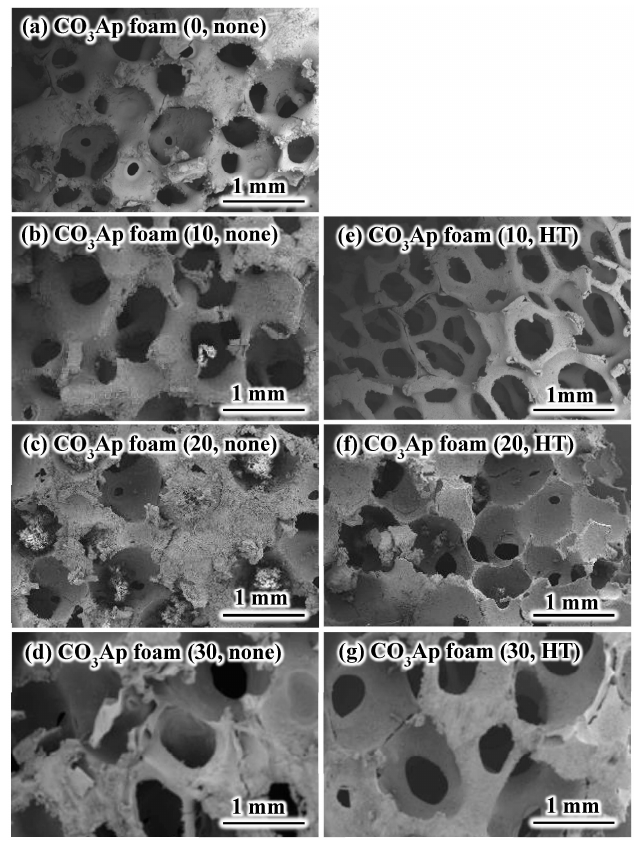
Figure 1. Typical scanning electron microscopy images of the CO 3 Ap foams: ( a ) CO 3 Ap foam (0, none); ( b ) CO 3 Ap foam (10, none); ( c ) CO 3 Ap foam (20, none); ( d ) CO 3 Ap foam (30, none); ( e ) CO 3 Ap foam (10, HT); ( f ) CO 3 Ap foam (20, HT); and ( g ) CO 3 Ap foam (30, HT).